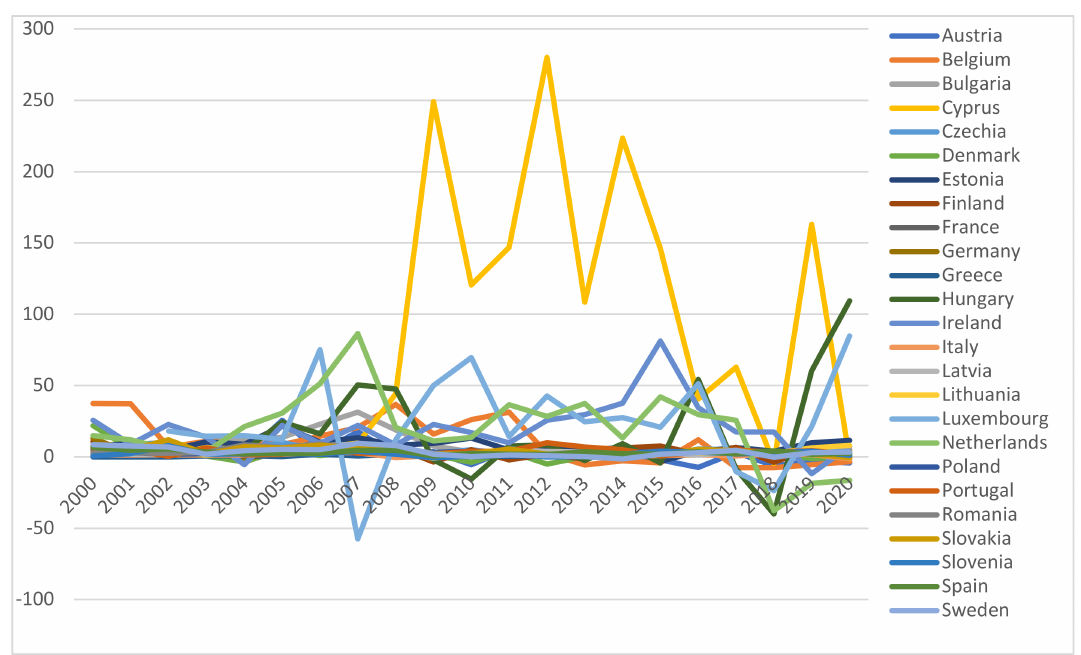
Figure 4. Evolution of foreign direct investments for 25 EU countries during